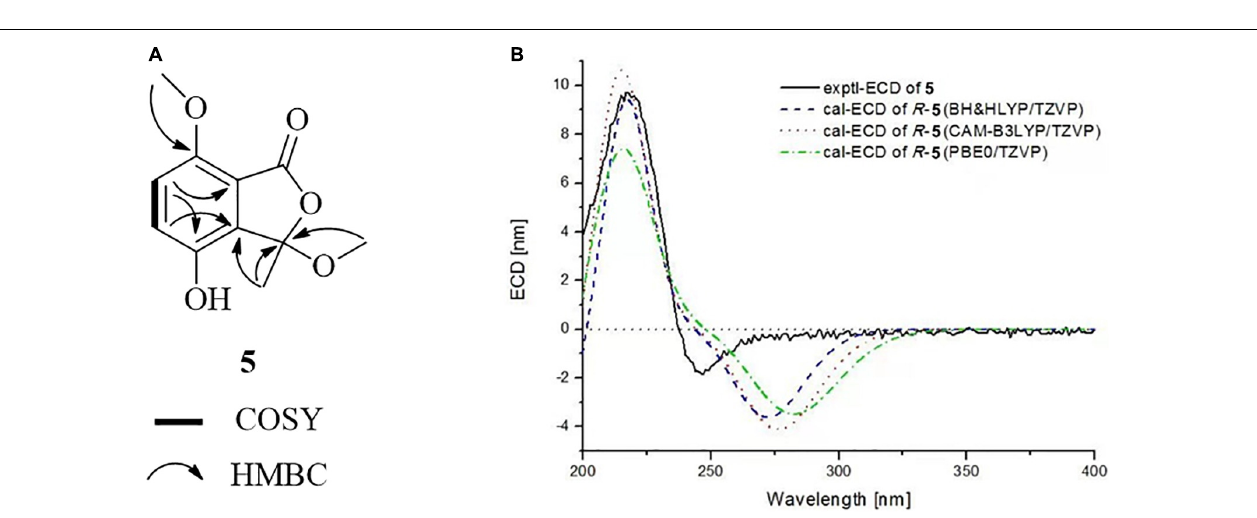
FIGURE 6 | (A) COSY and HMBC correlations of 5 . (B) Experimental and calculated ECD spectra of 5 in MeOH.